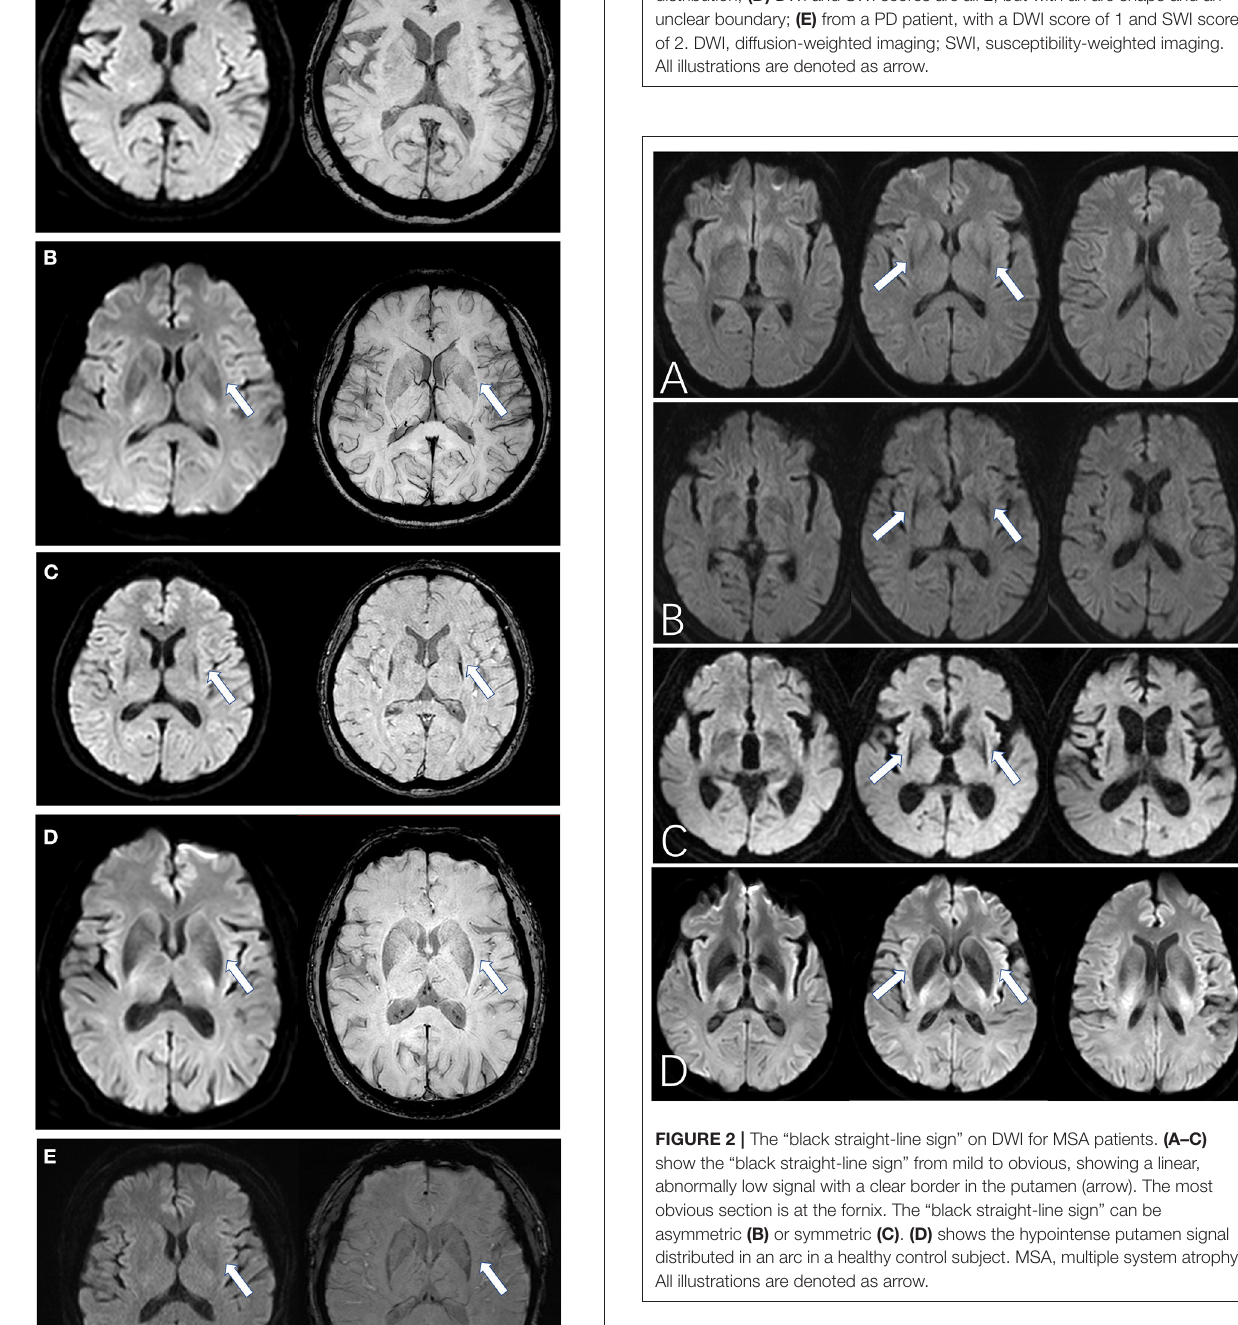
FIGURE 1 | score are all 0 as shown by an arrow; (B) DWI and SWI score are all equal to 1; (C) DWI and SWI scores are all 2 points, and in a straight distribution; (D) DWI and SWI scores are all 2, but with an arc shape and an unclear boundary; (E) from a PD patient, with a DWI score of 1 and SWI score